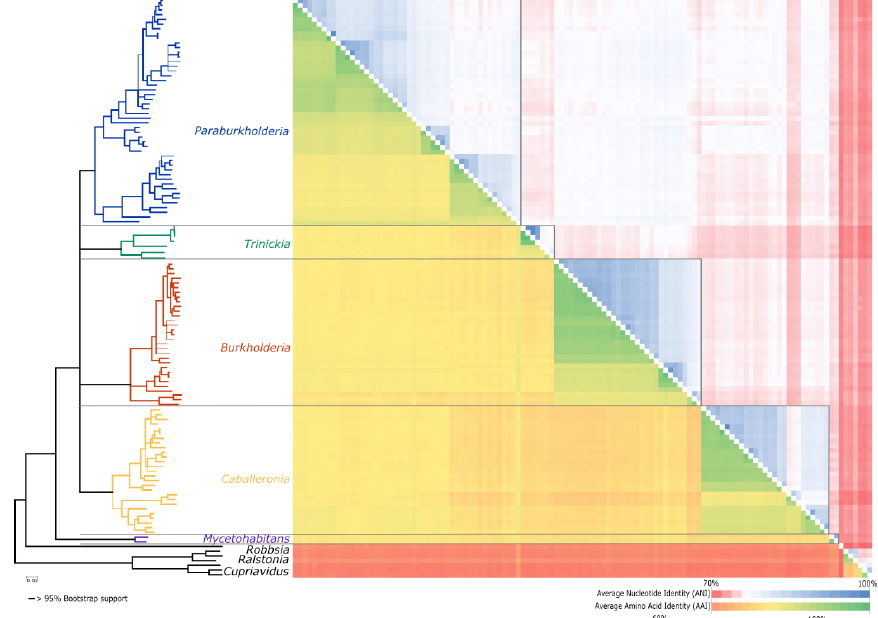
Figure 2. A heat map depicting the average amino acid and nucleotide identity values of the 122 Burkholderia sensu lato strains for which whole genomes are available. The cladogram indicating the various intra- and inter-generic relationships were inferred from the amino acid-based ML topology. Average nucleotide identity (ANI) values are indicated in the upper triangle of the map, with average amino acid identity (AVI) values indicated in the lower triangle of the map. For specific values, refer to Table S2